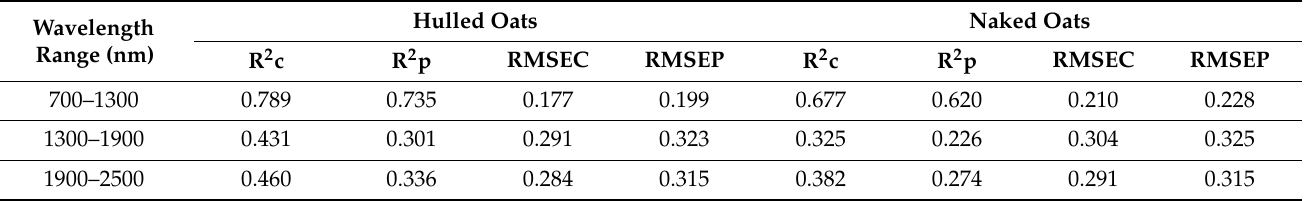
Table 3. Statistical results of partial least square regression models developed to predict the β -glucan content of hulled and naked oat